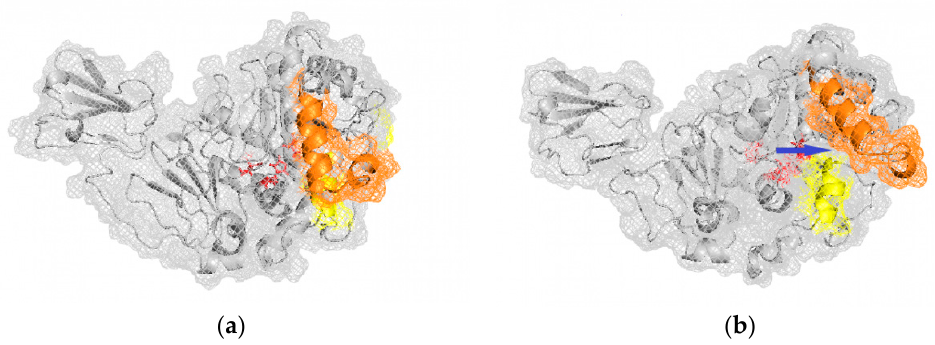
Figure 3. The conformation of the closed AMS8 lipase before and after simulation in the Triton X-100/toluene reverse micelle at 10 °C (shown in blue arrow). ( a ) Surface view of the initial structure of the closed AMS8 lipase before the molecular dynamics (MD) simulations. ( b ) Surface view of the final structure of the open AMS8 lipase after the MD simulations. Lid 1 and lid 2 are colored in yellow and orange, respectively. The active site is colored in red.